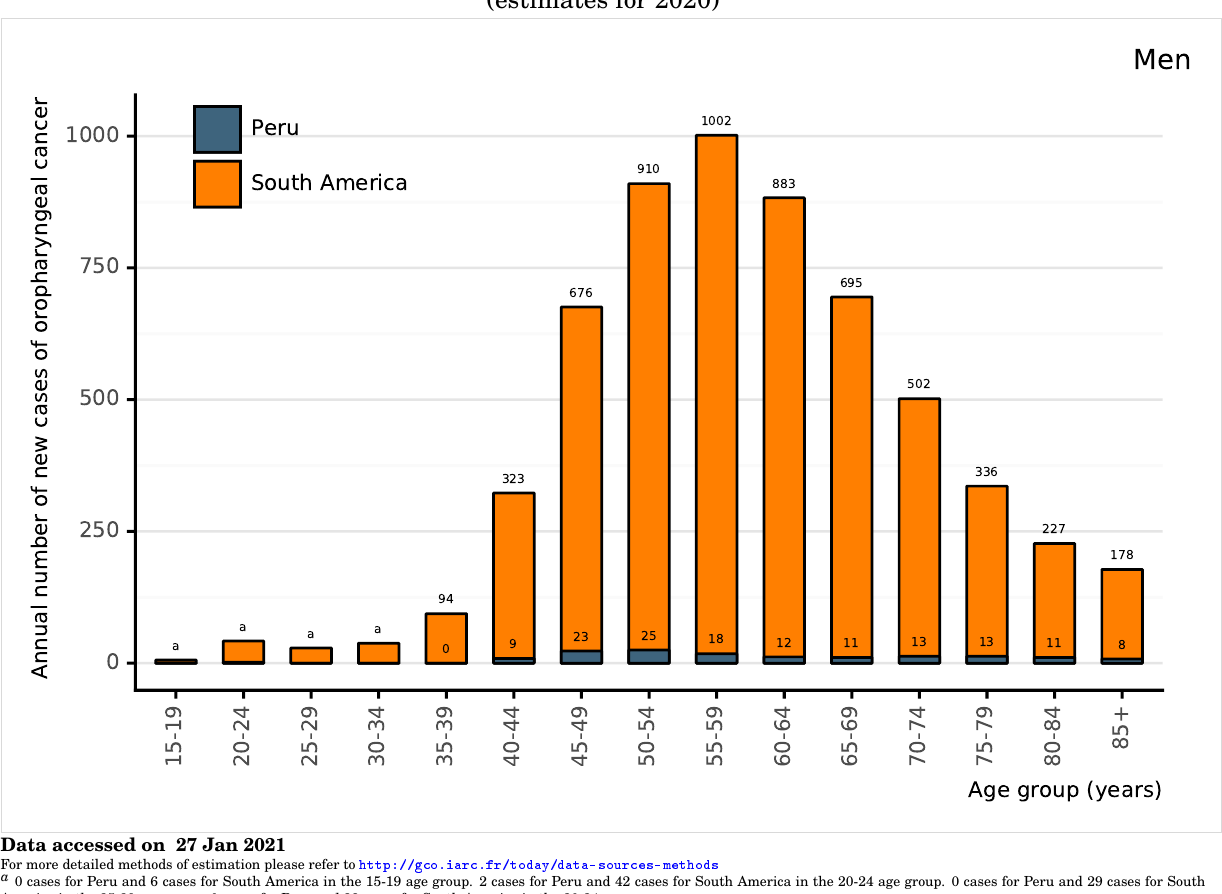
Figure 91: Annual number of new cases of oropharyngeal cancer among men by age group in